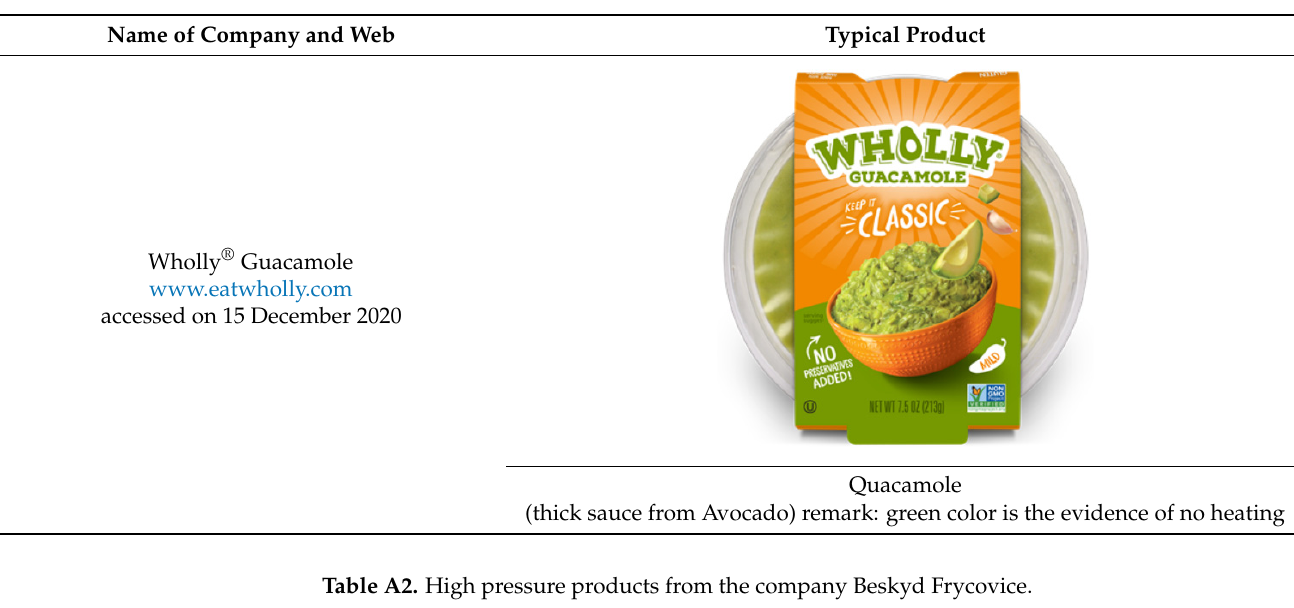
Table A1. High pressure guacamole product of the company Wholly ® Guacamole.